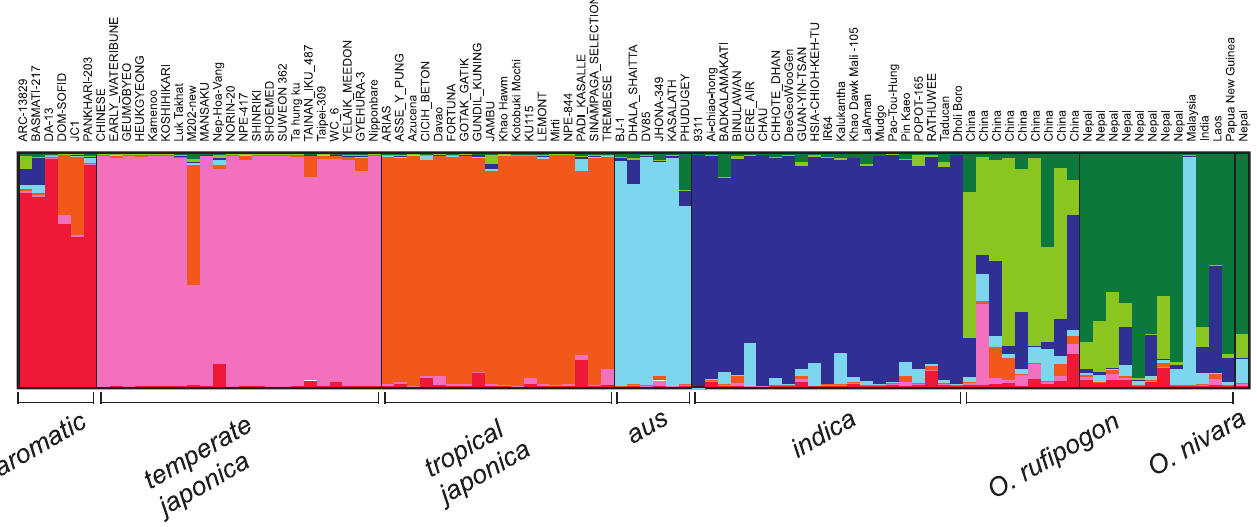
Figure 1. Estimated Population Structure for 97 Accessions of O . sativa and O . rufipogon from 111 STS Loci Vertical bars along the horizontal axis represent each Oryza accession; for all accessions, the proportion of ancestry under K ¼ 7 clusters that can be attributed to each cluster is given by the length of each colored segment in a bar.